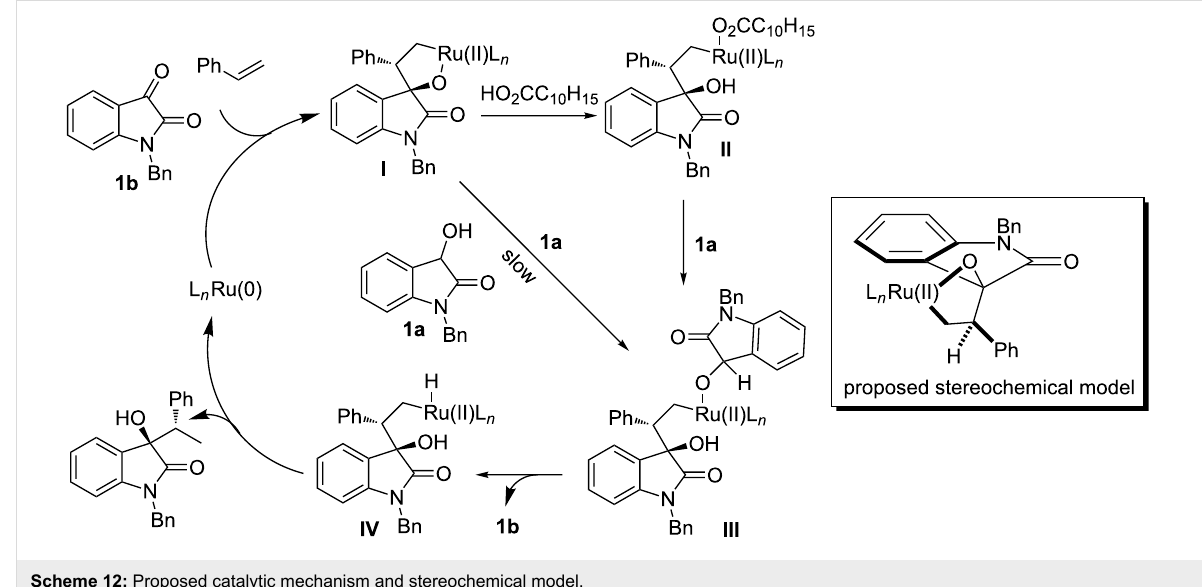
Scheme 12: Proposed catalytic mechanism and stereochemical model.